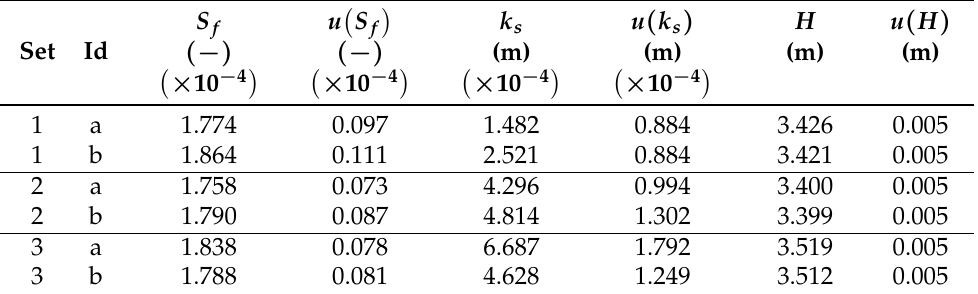
Table 3. Optimal state variables and their associated uncertainties in section GG11 from SE. Coverage coefficient— k = 1.